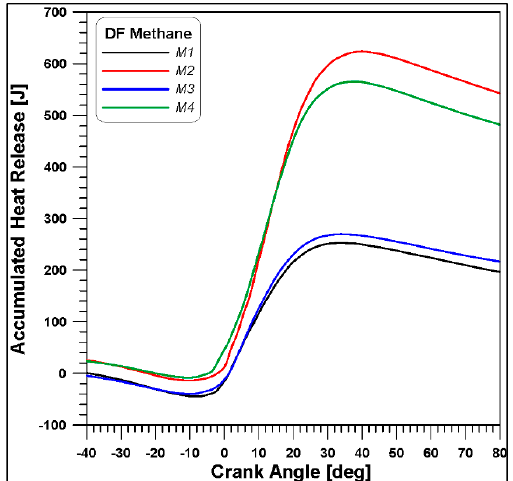
Figure 4. Experimental heat release rate. Cases with hydrogen.